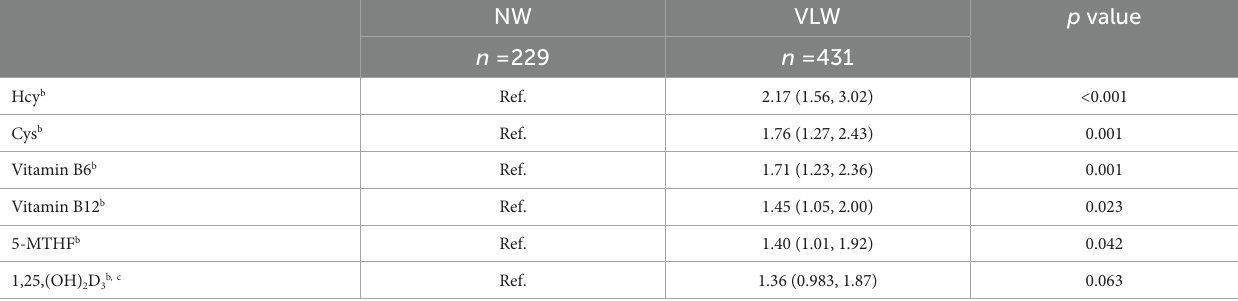
TABLE 1 Associations of long-term low-mineral DDW exposure between Hcy, metabolites of Hcy, and important cofactors in Hcy metabolism. a